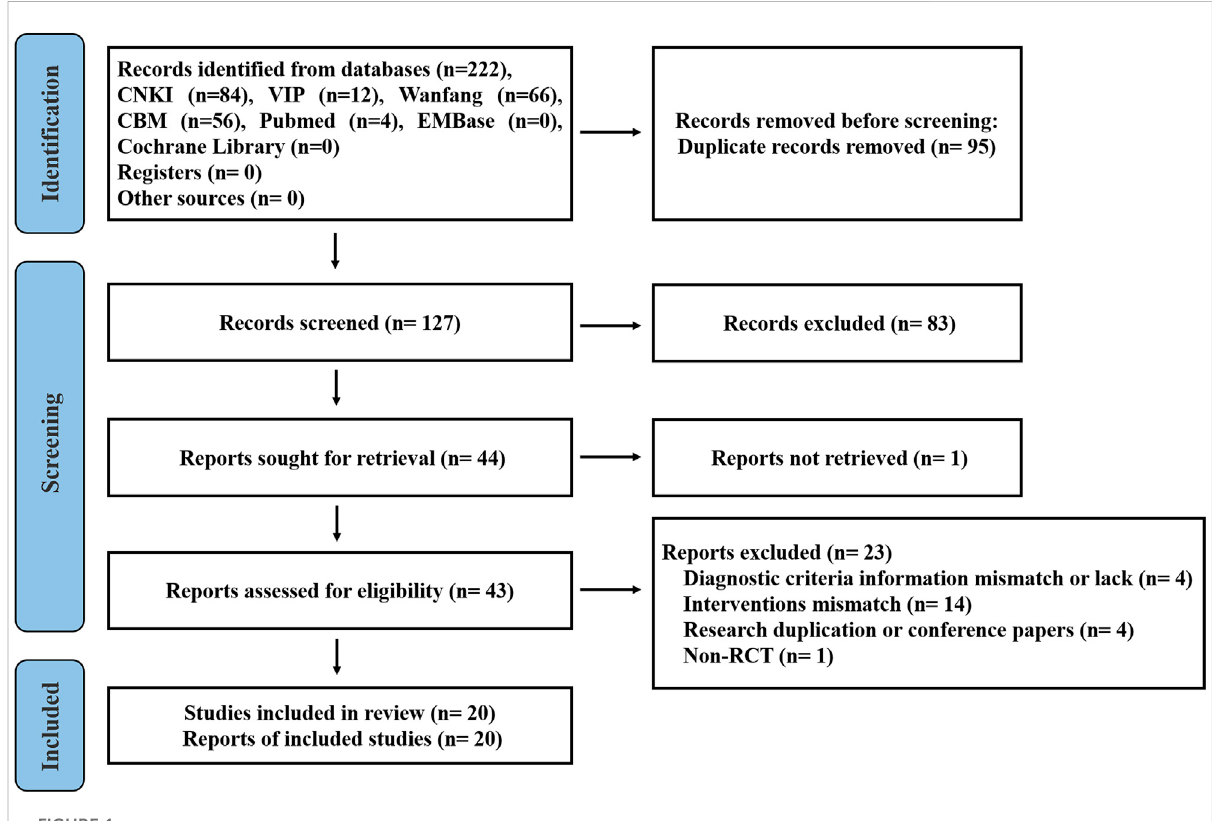
FIGURE 1 Flow diagram depicting the study selection